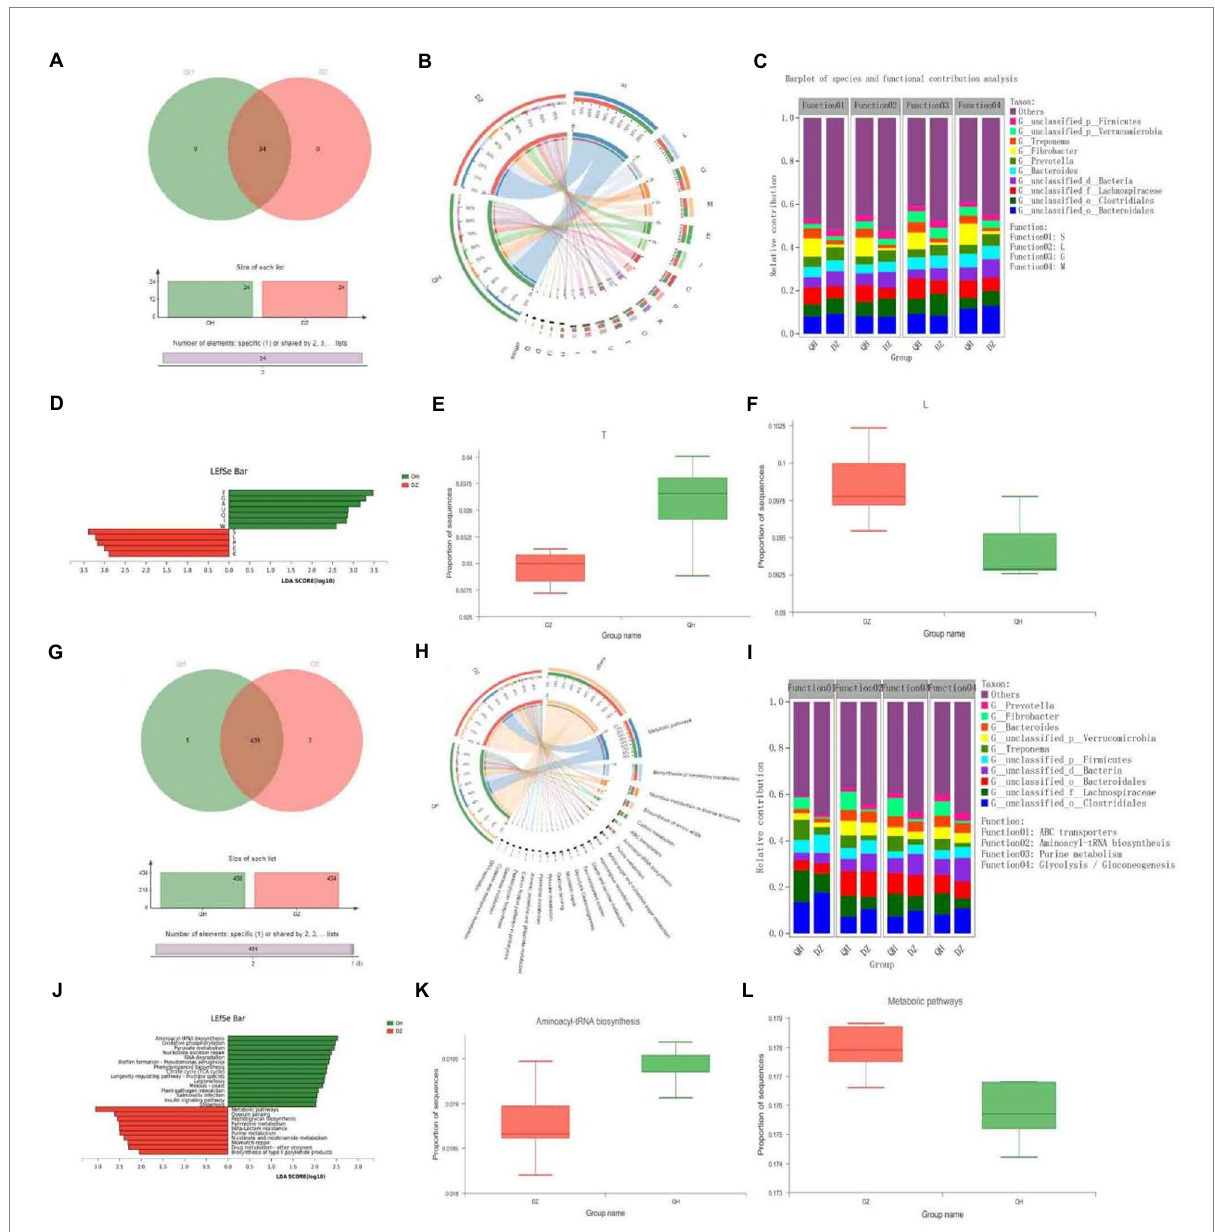
FIGURE 4 Functional composition and differences. Venn Figures in COG (A) and KEGG (G) . Overlapping parts indicate functions common to multiple sample groups; non-overlapping parts indicate functions unique to the sample group; and numbers indicate the number of corresponding functions. Circos Figures in COG (B) and KEGG (H) . The left semicircle (smaller circle) represents the functional abundance composition of the sample, and the right semicircle (larger circle) represents the distribution ratio of functions in different samples under this clustering-level condition. Species and functional contributions were shown in COG (C) and KEGG (I) ; the abscissas were the corresponding sample groups, and the ordinates were the relative contributions. LDA discriminant histogram in COG (D) and KEGG (J) : the abscissa is the LDA score—the greater the LDA score, the greater the influence of species abundance on the differential effect—and different colors represent different groups. Difference test box in COG (E,F) and KEGG (K,L) : The abscissa represents the grouping category name, and the ordinate represents the percentage of species abundance in a sample